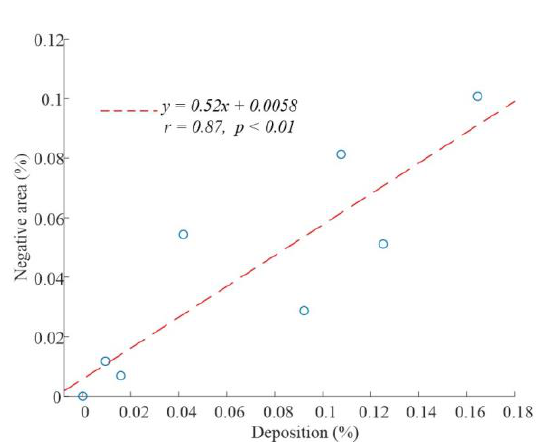
Figure 7 . the relation between negative transport and deposition.